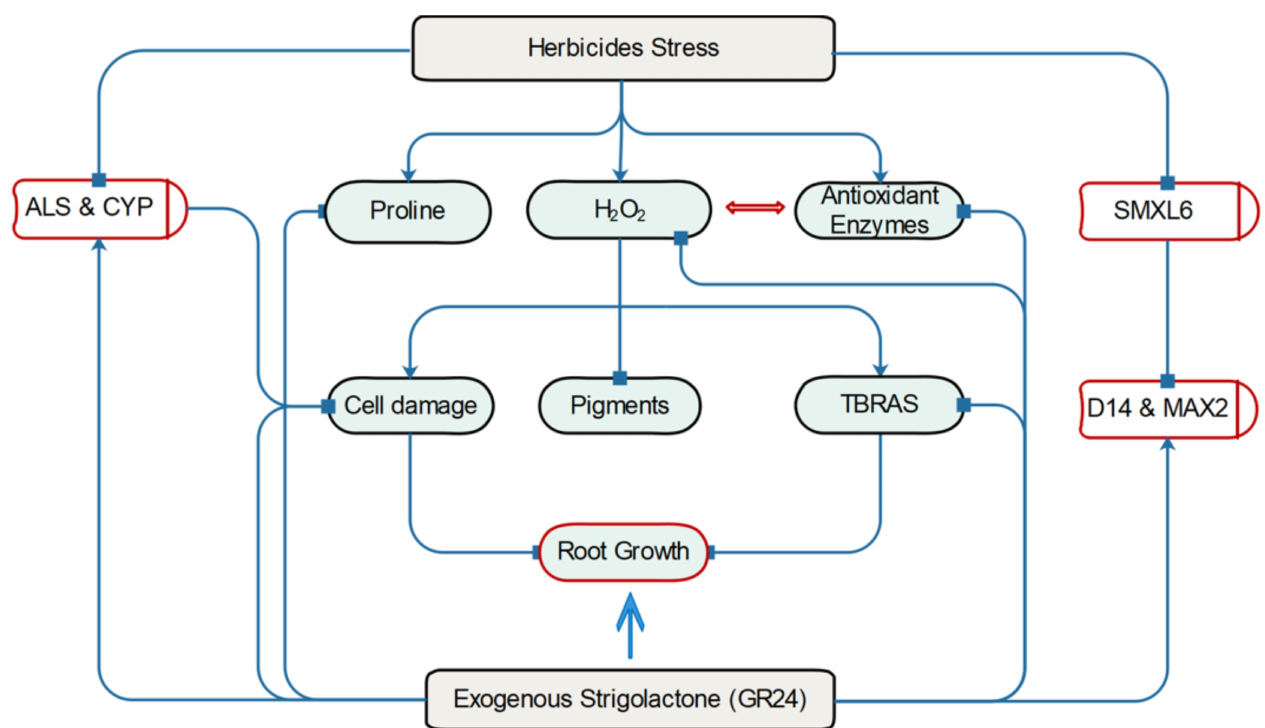
Figure 7. The schematic presentation of the alleviatory role of SL against herbicide stress in watermelon. Herbicides induce proline, H 2 O 2 , and antioxidant enzymes and suppress the negative regulator (SMXL6) of strigolactone biosynthesis (D14 and MAX2). This effect of herbicides negatively affects the expression of CYP and ALS genes. The exogenous application of GR24 restores the negative effects of PXL and BSM and enhances the root growth and development in herbicide-treated watermelon.